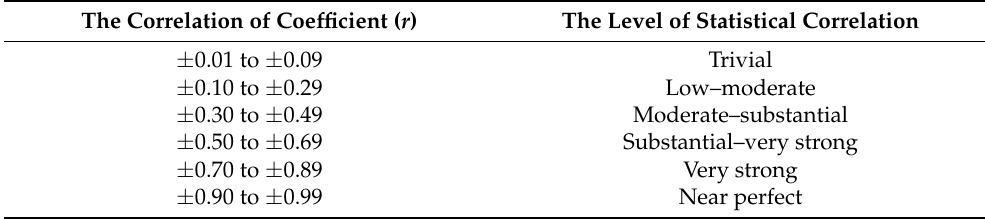
Table 1. The correlation coefficient ( r ) with the level of statistical correlation [42]. The Correlation of Coefficient ( r ) The Level of Statistical Correlation ± 0.01 to ± 0.09 Trivial ± 0.10 to ± 0.29 Low–moderate ± 0.30 to ± 0.49 Moderate–substantial ± 0.50 to ± 0.69 Substantial–very strong ± 0.70 to ± 0.89 Very strong ± 0.90 to ± 0.99 Near